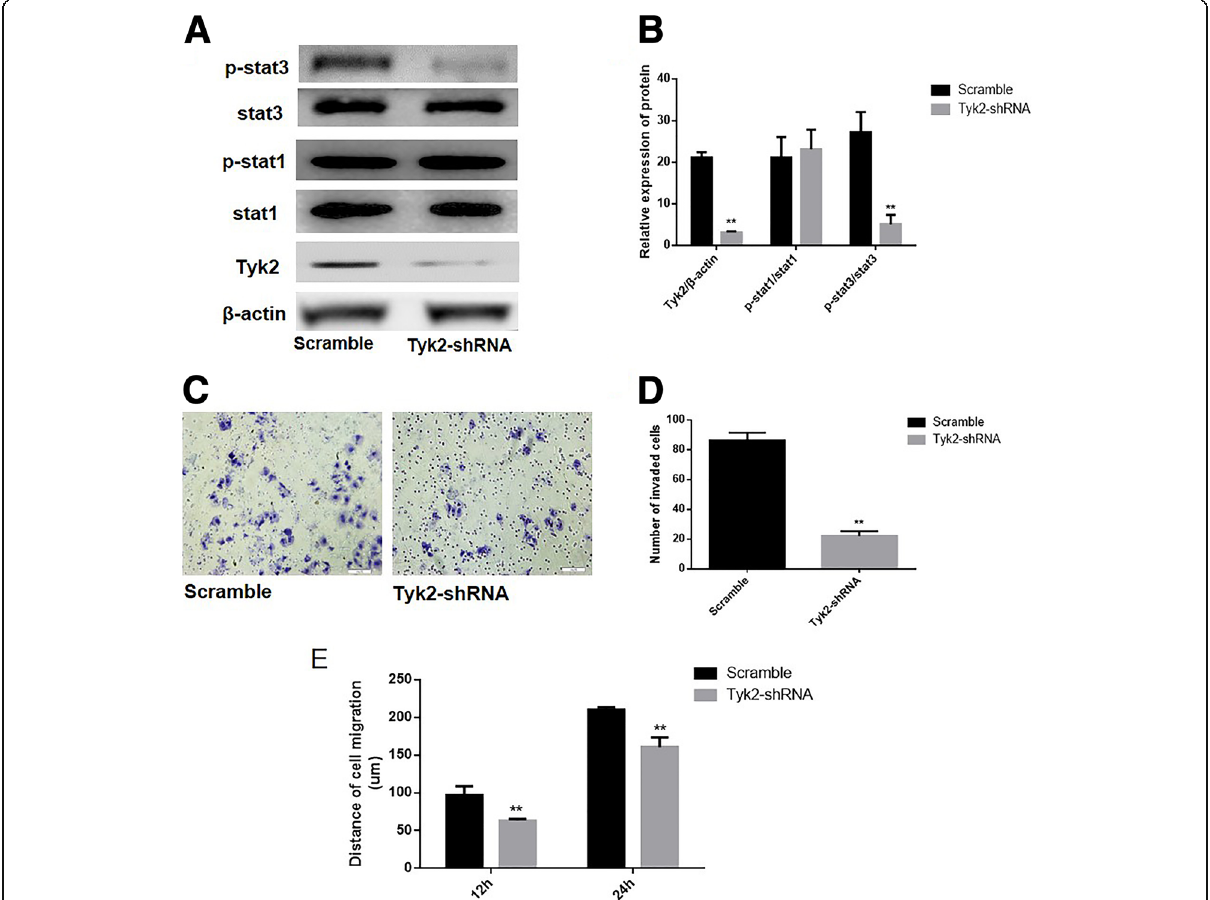
Fig. 5 RNAi was utilized to silence Tyk2 expression in CLDN17-expressing cells. a Western blotting was utilized to examine the effects of silencing Tyk2 and activating the Stat3 signaling pathway in the HL7702 cell line; ( b ) The corresponding statistical analysis of the activation of the Stat3 signaling pathway; ( c ) The Transwell chamber method was utilized to detect the impact of Tyk2 silencing on the invasive ability of the cells in vitro; ( d ) The corresponding statistical analysis of invaded cells; ( e ) A wound healing assay was utilized to detect the migration ability of the HL7702 cell line in vitro. Note: * represents P < 0.05 and ** represents P < 0.01 compared with the scramble